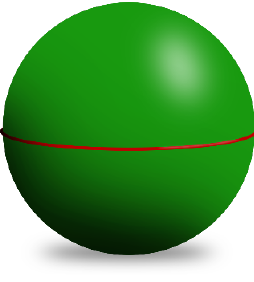
Figure 4 . A string wrapping the equator of a ( p +